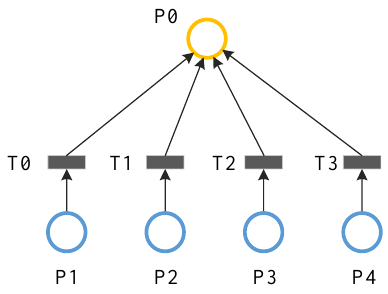
Figure 8. Petri net diagram of Load B failure.